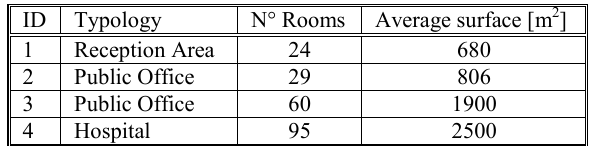
Table 1: Sites surveyed during the tests